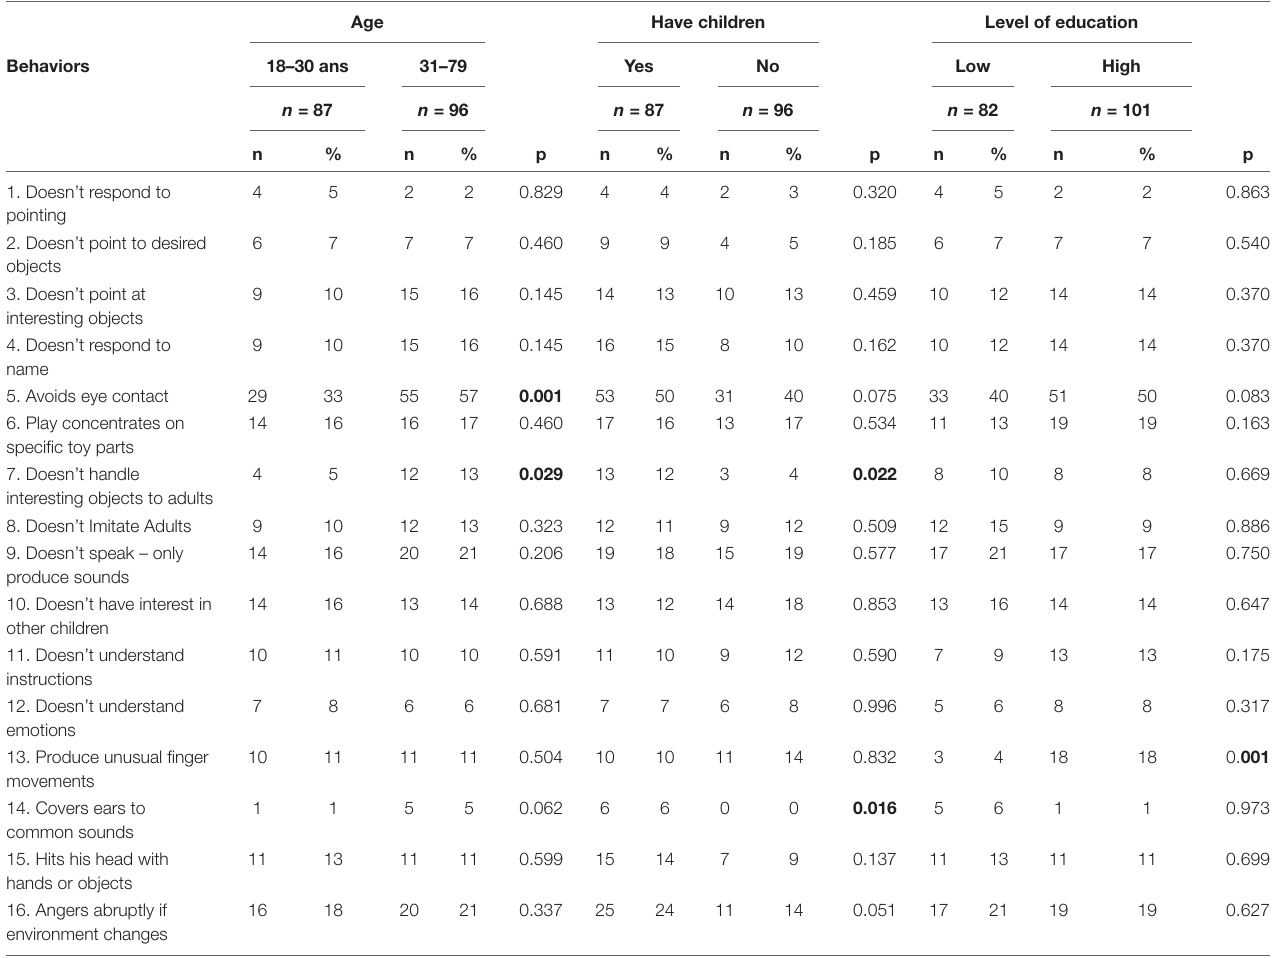
TABLE 5 | Differences of proportions of participants identifying 16 behaviors as a symptom of a developmental disorder, as a function of age, parenthood, and level of education. Age Have children Level of education